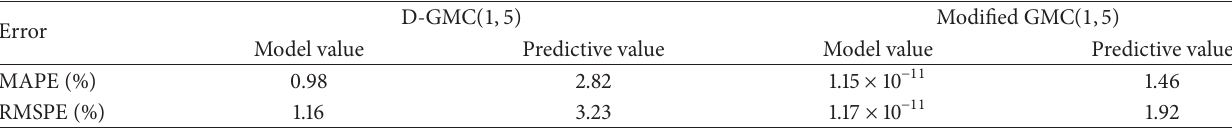
Table 5: Performance evaluation for fitting and prediction accuracies of D-GMC (1,5) , and modified GMC (1,5) models.